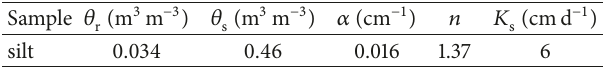
Table 2: Soil hydraulic properties used in numerical